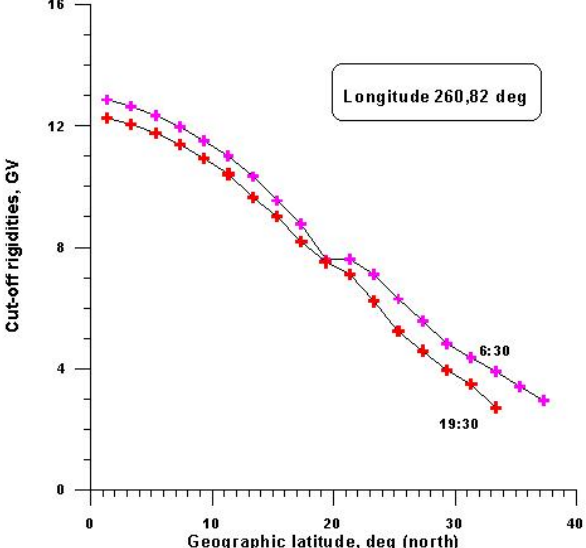
Fig. 4. Variations of the cutff rigidity along the geographic parallel of the Mexico station for the quiet conditions (pink) and at the peak of magnetic storm on 20 November 2003 (red).